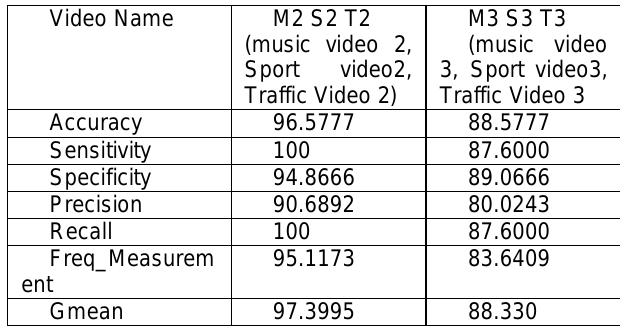
Table 1. Performance Evaluation